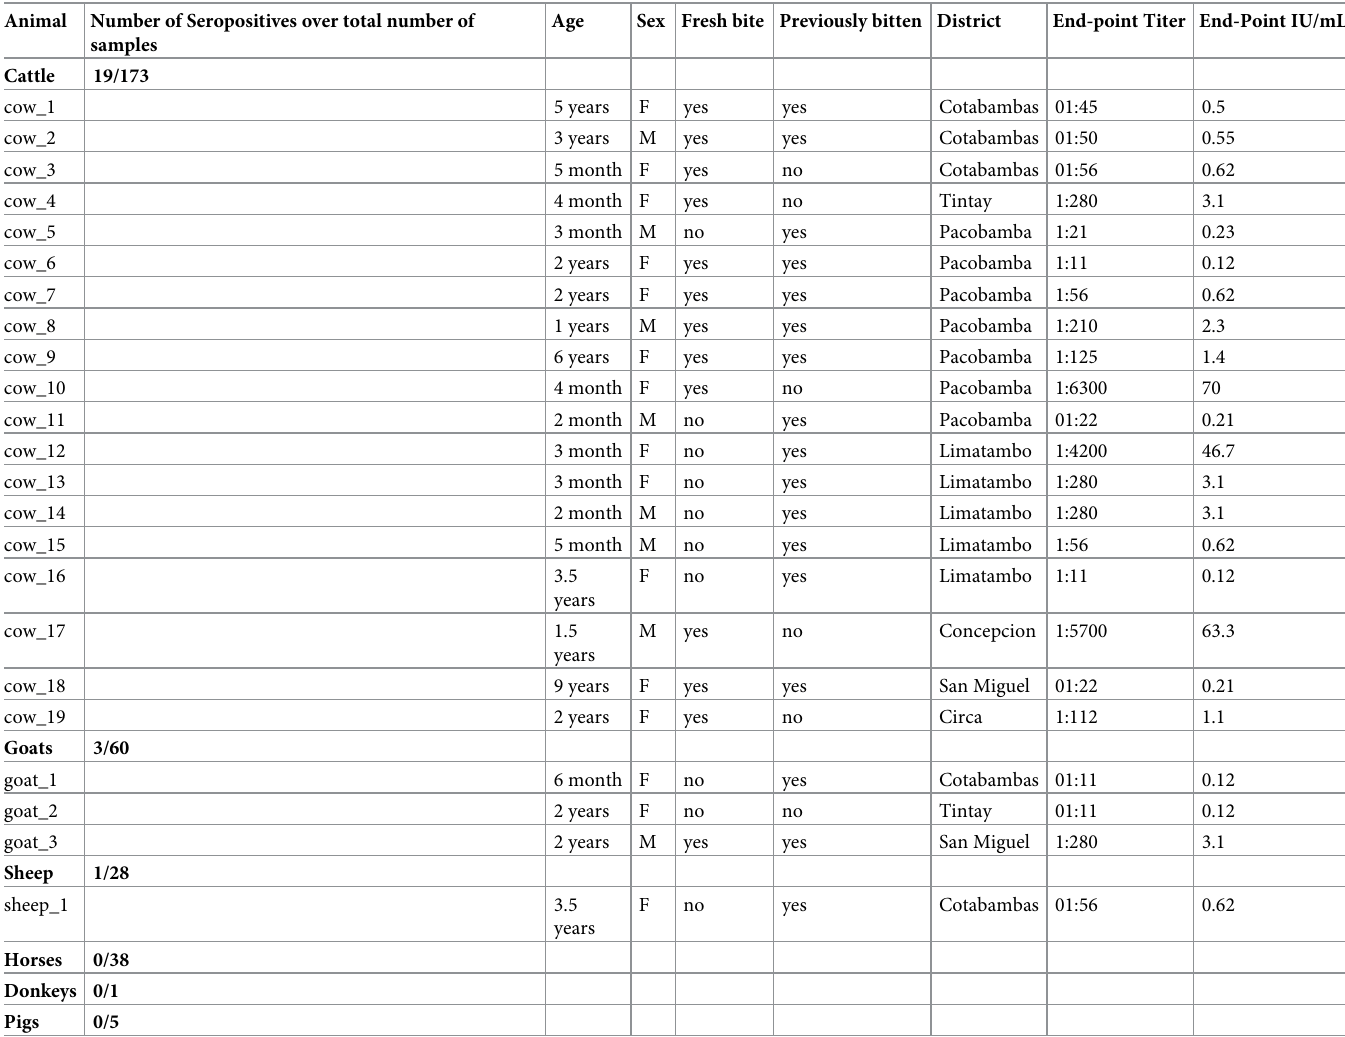
Table 1. Characteristics of seropositive animals. Animal Number of Seropositives over total number of